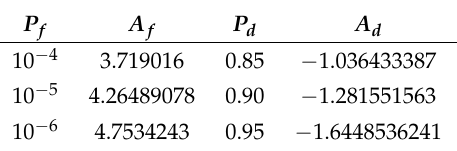
Table 5. Relationship between A f and P f and A d and P d ,